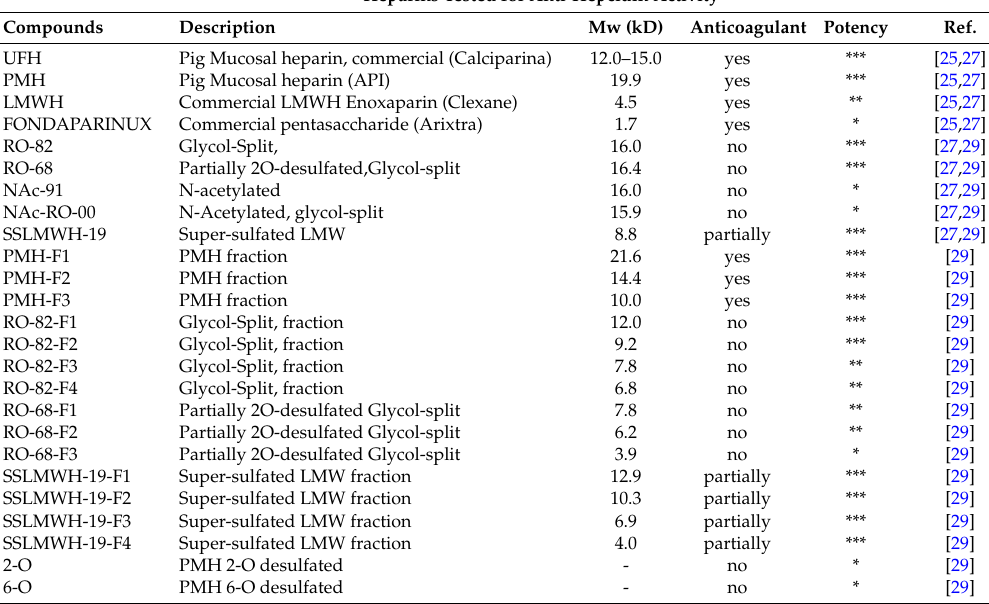
Table 1. List of the heparins tested for the anti-hepcidin property in vitro and/or in vivo. These include anti-coagulant and non-anticoagulant heparins as indicated. The main features and the anti-hepcidin potency (*** strong anti-hepcidin activity/** intermediate anti-hepcidin activity/* low anti-hepcidin activity) of the heparins are described. The fractions of fractionated heparins are coded as F plus a